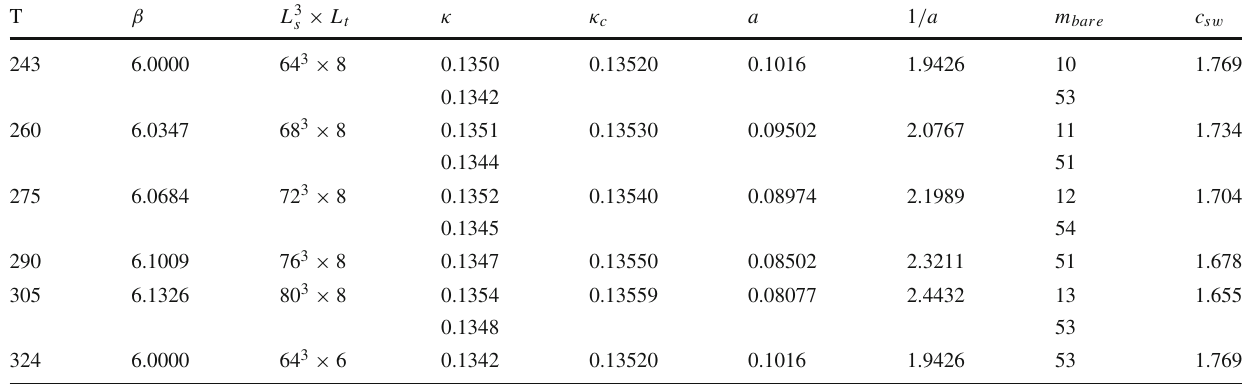
Table 1 Lattice setup for the computation of the quark propagator in the quenched approximation. The coefficient c s w associated with the non-perturbative improvement of the simulations and κ c are taken from